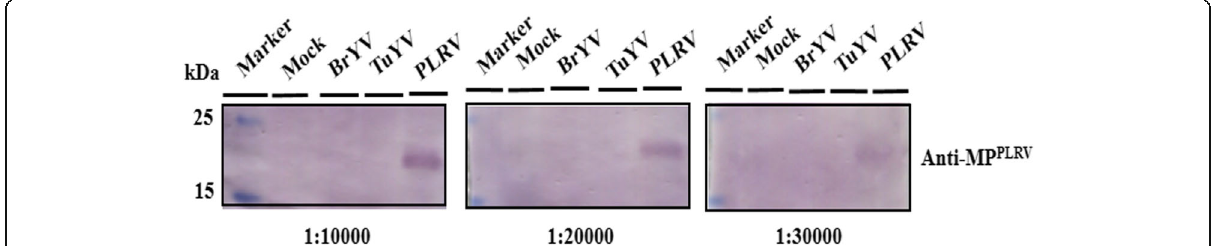
Fig. 4 Specificity analysis of PLRV-MP antiserum (anti-MP PLRV ) by Western blotting. Marker: PageRuler Prestained Protein Ladder, Mock: protein extracted from the healthy leaf was used as a negative control, and the rest of the lanes are for the protein extracted from Nicotiana benthamiana leaves infected by Brassica yellow virus , Turnip yellows virus and Potato leafroll virus , respectively